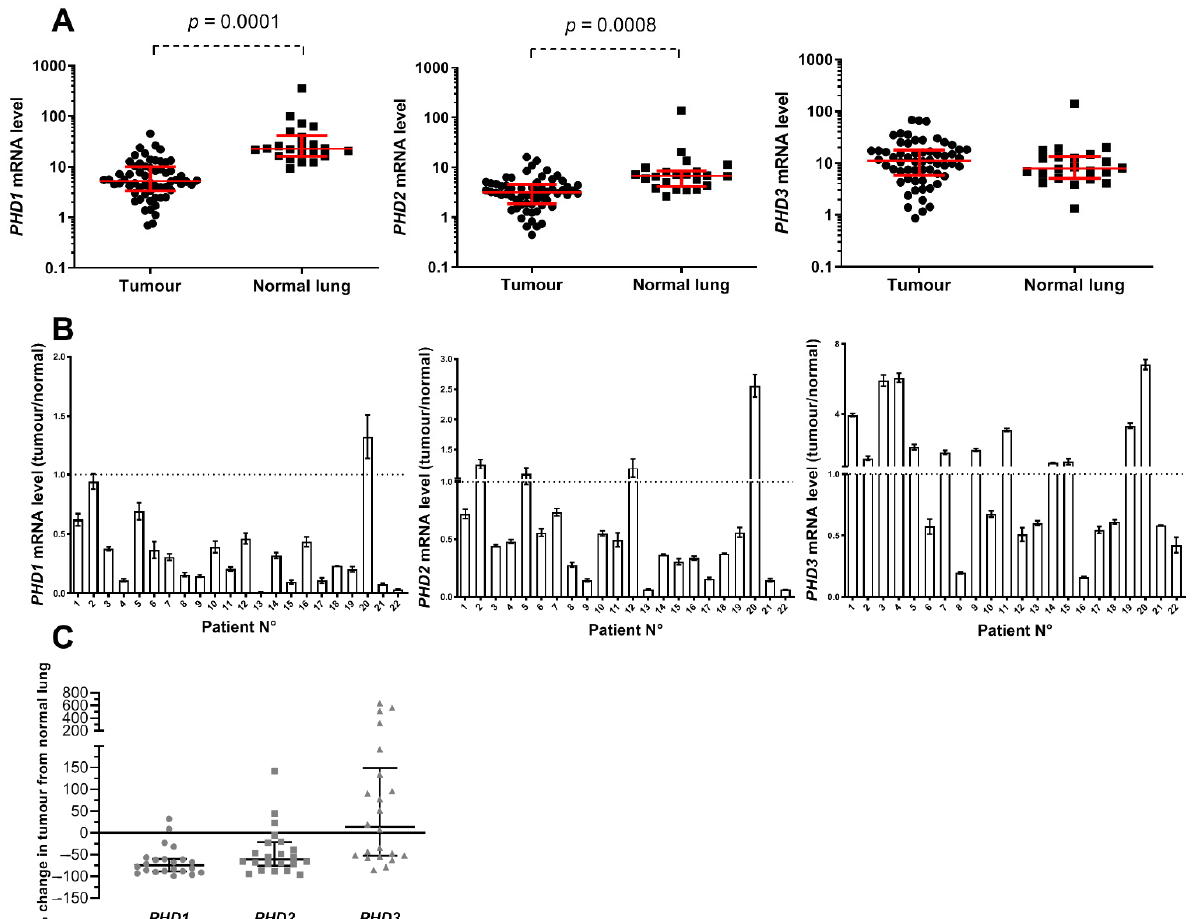
Figure 1. mRNA expression of PHD1 , PHD2 in PHD3 in primary non-small-cell lung cancer (NSCLC) and normal lung samples. ( A ) mRNA expression levels of PHD1 , PHD2 and PHD3 in 60 primary NSCLC and 22 normal lung tissue samples. The horizontal lines represent the median and interquartile range. ( B ) mRNA expression levels of PHD1 , PHD2 and PHD3 in 22 primary NSCLC and matched normal lung tissue samples. PHD mRNA expression levels from the same patient were combined together, each bar representing the ratio between PHD mRNA level in the primary tumour vs. the adjacent normal lung. Means of three independent experiments ± SD are shown. ( C ) PHD mRNA percentage changes in 22 primary NSCLC compared with matched normal lung tissue samples. PHD mRNA expression levels from the same patient were combined together, and each dot represents the percentage change in the expression of a specific PHD in tumour compared with normal lung samples. The horizontal lines represent median values with interquartile ranges.